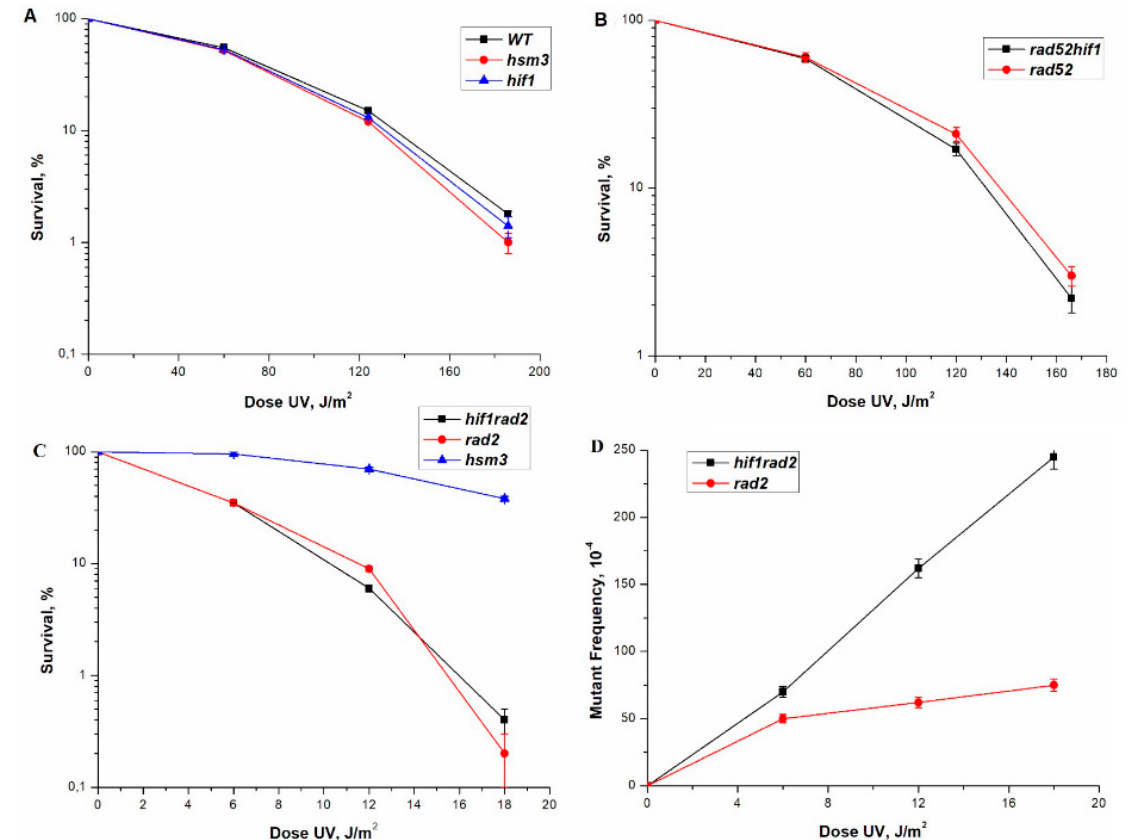
Figure 1. Sensitivity and mutagenesis in various mutant strains at different UV doses. Cells were irradiated at the indicated dose, the viable titer was determined, and the percentage of survivals was calculated. The mutation frequencies were determined, as a ratio of the number of white colonies to the number of all colonies grown in a cup with complete medium. The mean ± SEM values obtained from four independent experiments are plotted. ( A ) UV-induced sensitivity in strain wild-type (LMG-3031) and mutant strains hsm3 Δ (5-LGM-3031), hif1 Δ (CAY-3); ( B ) UV-induced sensitivity in mutant strains rad52 Δ hif1 Δ (CAY-13) , rad52 Δ (10-CAY-3031); ( C ) UV-induced sensitivity mutagenesis in mutant strains hif1 Δ rad2 Δ (CAY-12), rad2 Δ (LGM-352), hsm3 Δ (5-LGM-3031); ( D ) UV-induced mutagenesis in mutant strains hif1 Δ rad2 Δ (CAY-12), rad2 Δ (LGM-352).